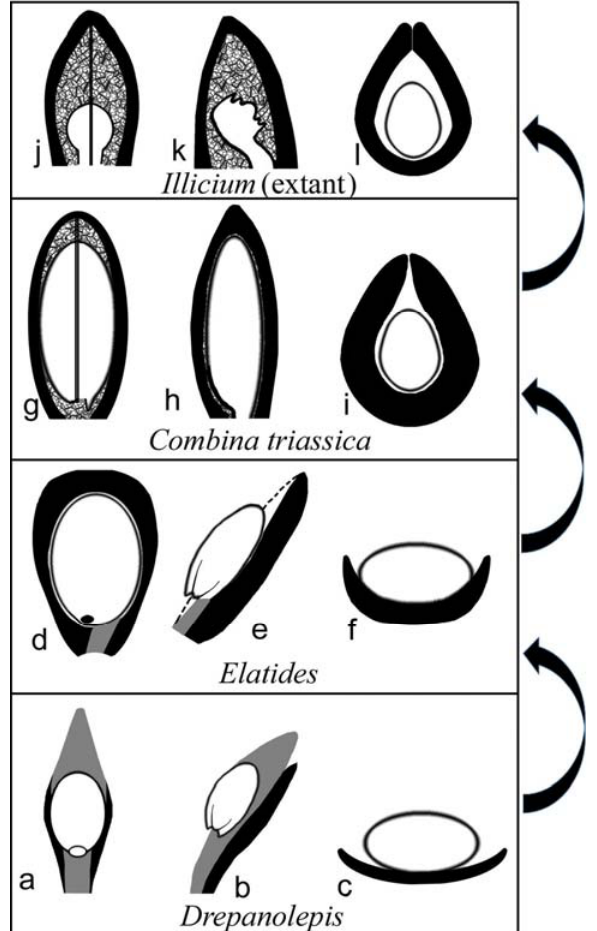
Figure 4. Proposed possible evolutionary roadmap related to Combina gen. nov., from a conifer ( Drepanolepis ) to extant Illicium . The scale/funiculus is in dark gray, the ovule is in white, and the bract is in black. ( a – c ) Adaxial, lateral, and cross view of a lateral unit in Drepanolepis . ( d – f ) Adaxial, lateral, and cross view of a lateral unit in Elatides 23 . Note the wings of the bract curving adaxially. ( g – i ) Adaxial, lateral, and cross view of a lateral unit in Combina gen. nov. Note the axillary ovule is almost fully enclosed except along the ventral suture (gap). ( j – l ) Adaxial, lateral, and cross view of a carpel in extant Illicium (Illiciaceae).